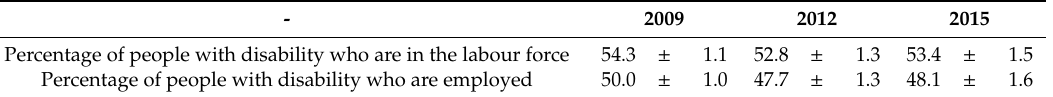
Source: Table 15A.73 and 5A.74